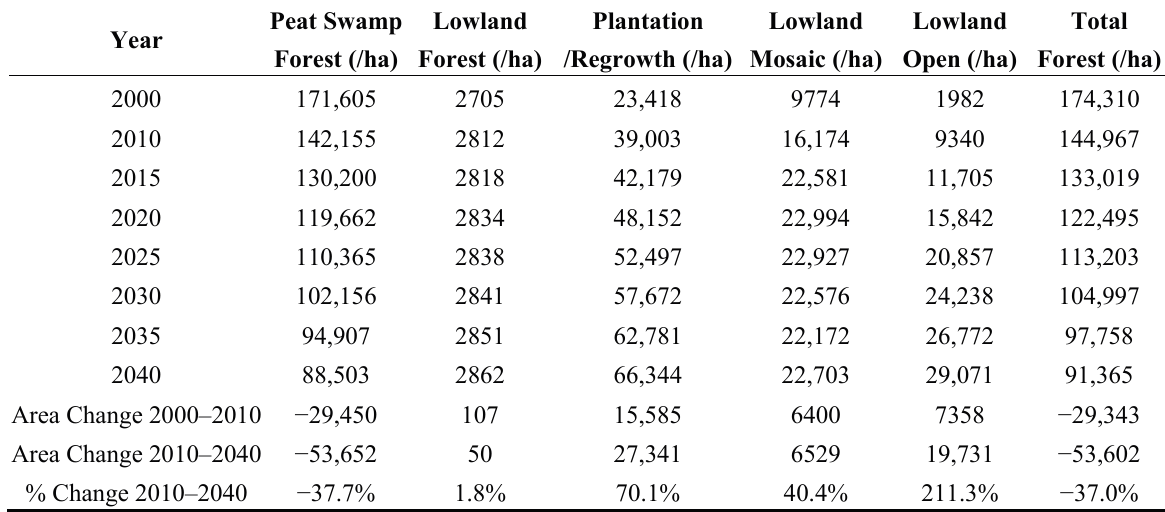
Table 6. Land Cover Change (ha) in Peat Soil Areas. (Category Mangrove is not present in Peat Soil